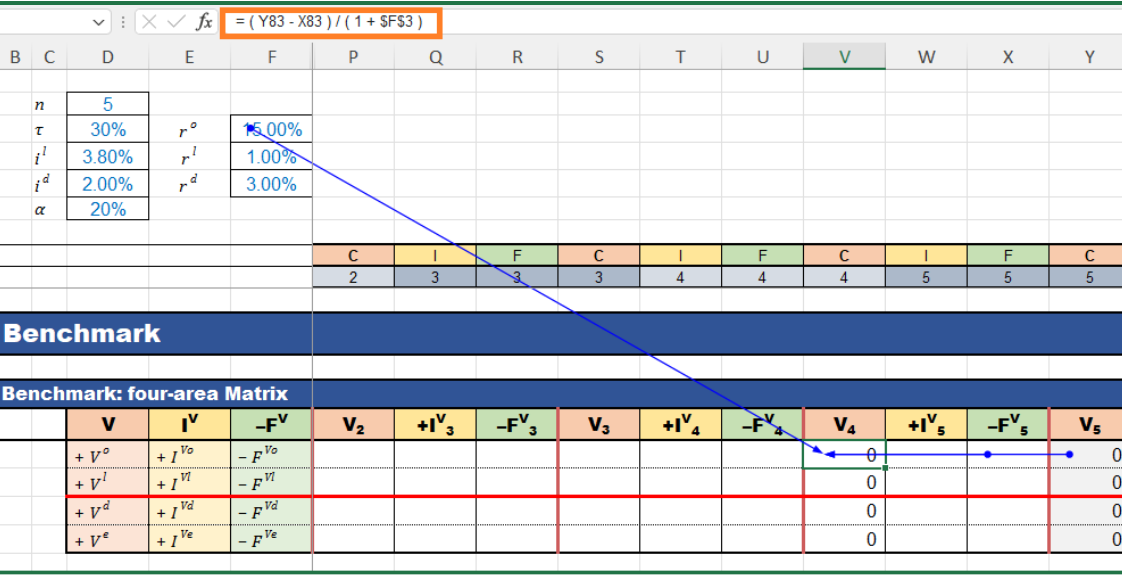
as a function of 4